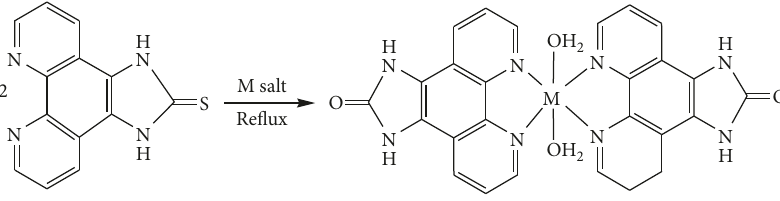
Scheme 3: Formation of M (II) complex, where M � Ni and Cu.